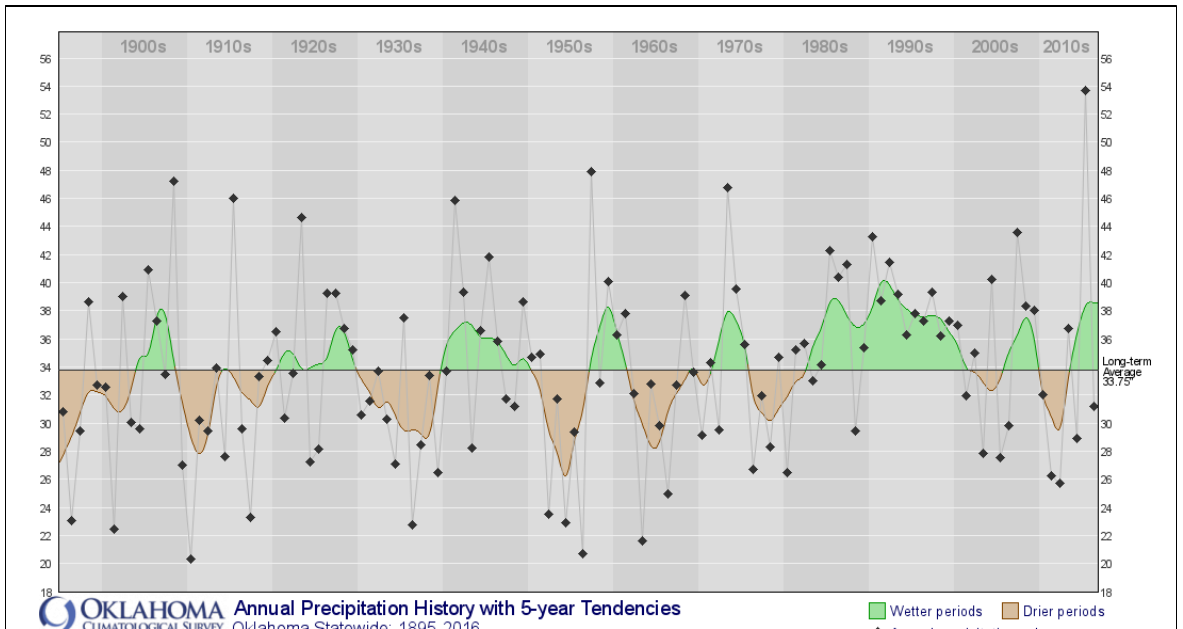
Figure 1. Oklahoma’s Annual Precipitation History with 5-Year Tendencies, Statewide, for 1895 to 2016